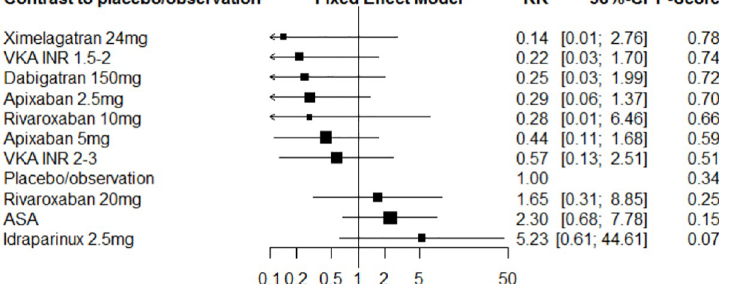
Fig 4. Relative risks (95% confidence interval) for net clinical benefit (A) and death related to fatal recurrent venous thromboembolism and major bleeding (B) in network meta-analysis versus observation or placebo. ASA: aspirin; INR: international normalized ratio; VKA: vitamin k